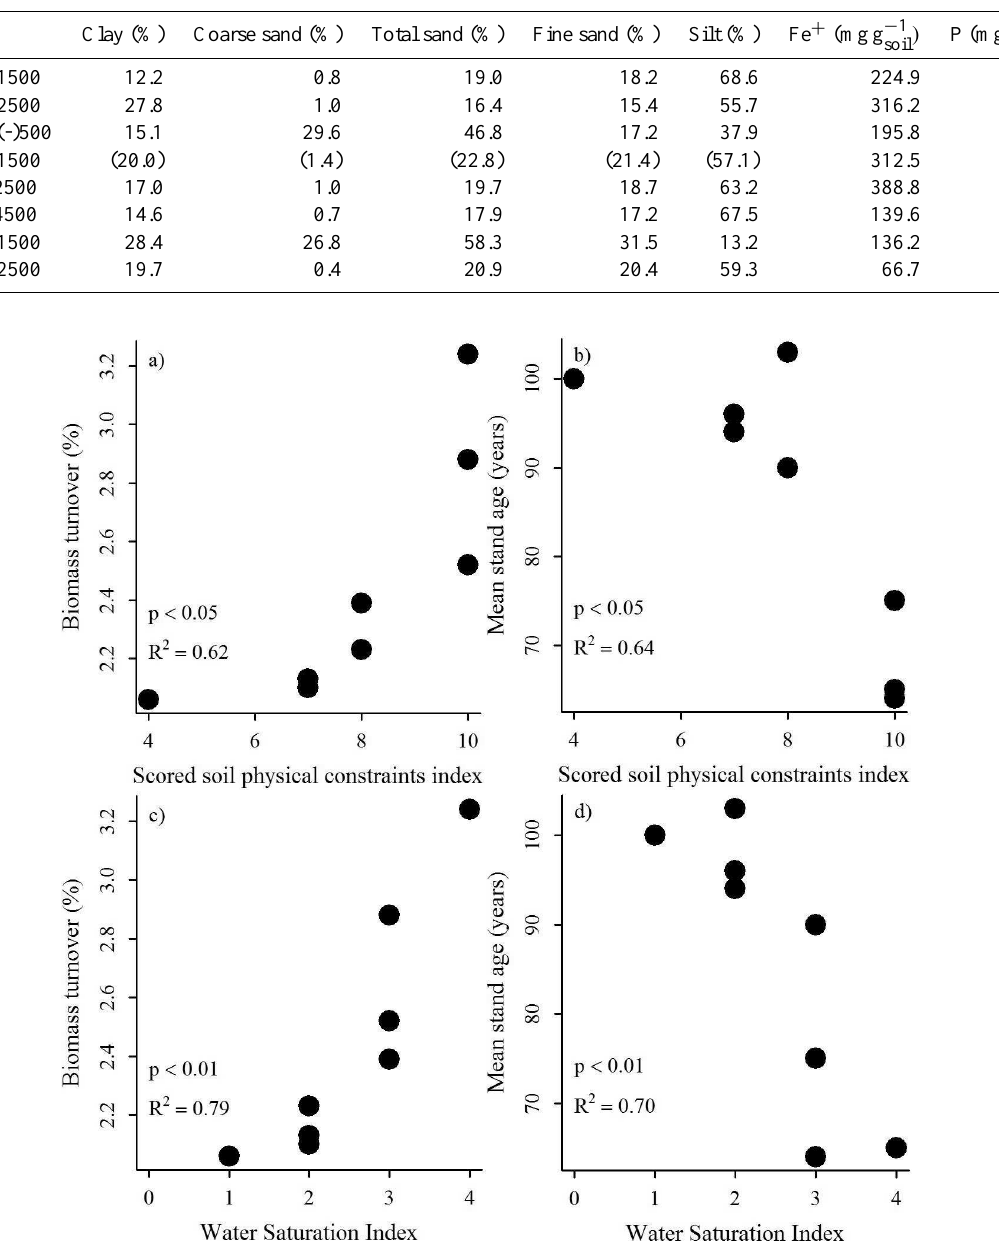
Table 5. Chemical and physical soil properties obtained from 30cm depth of composited soil samples for each study site. Numbers in parentheses indicate values obtained for 10cm soil depth.